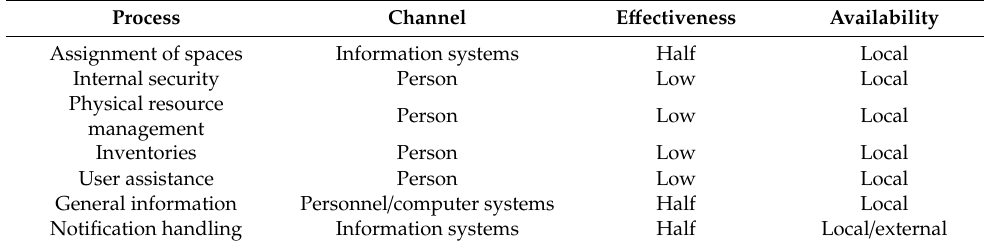
Table 1. Processes carried out through a traditional request